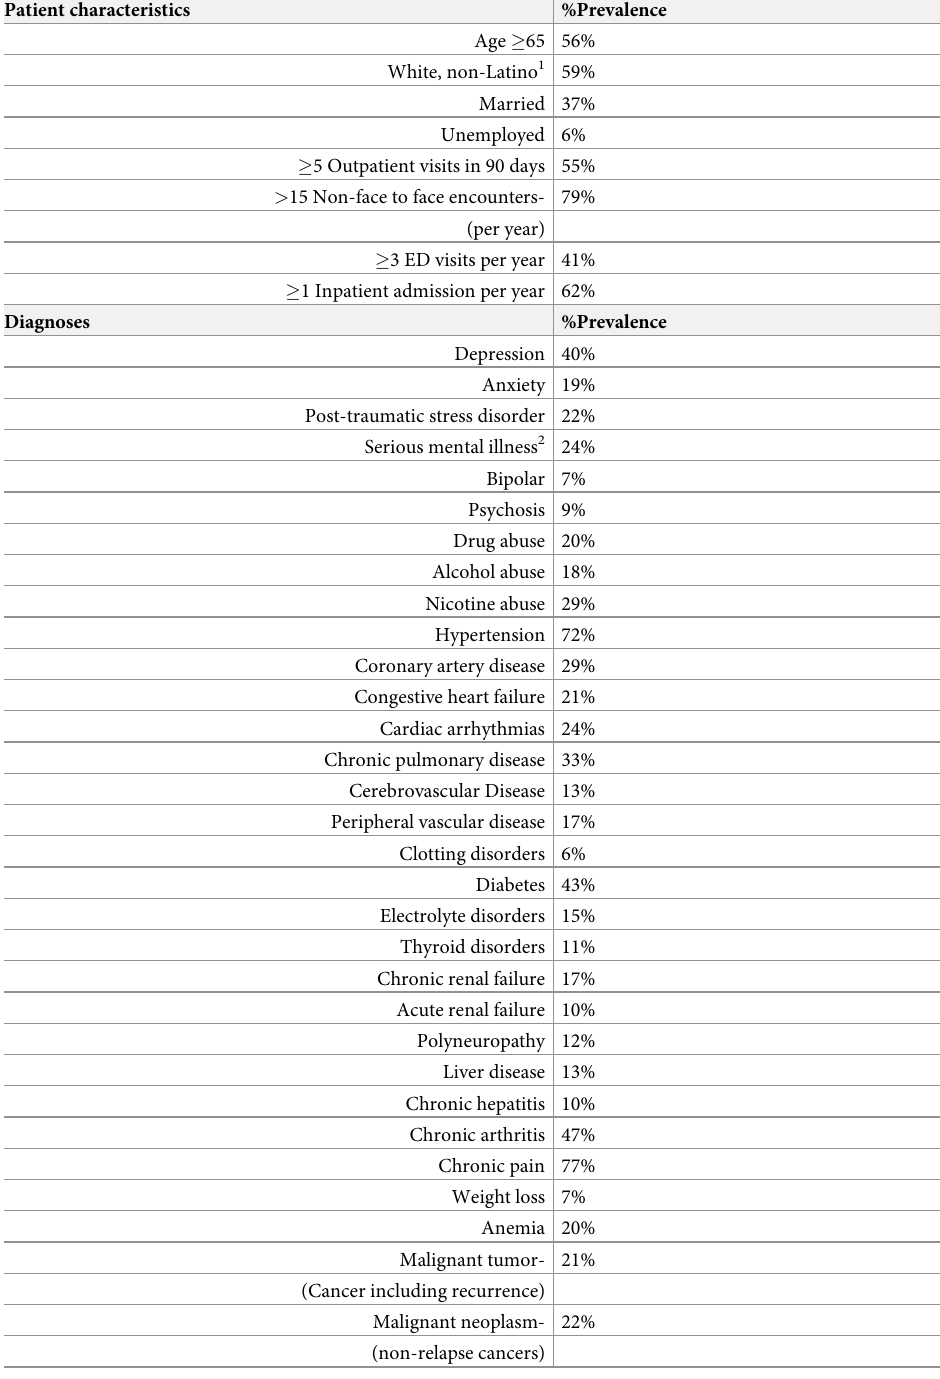
Table 1. Study sample characteristics (N =